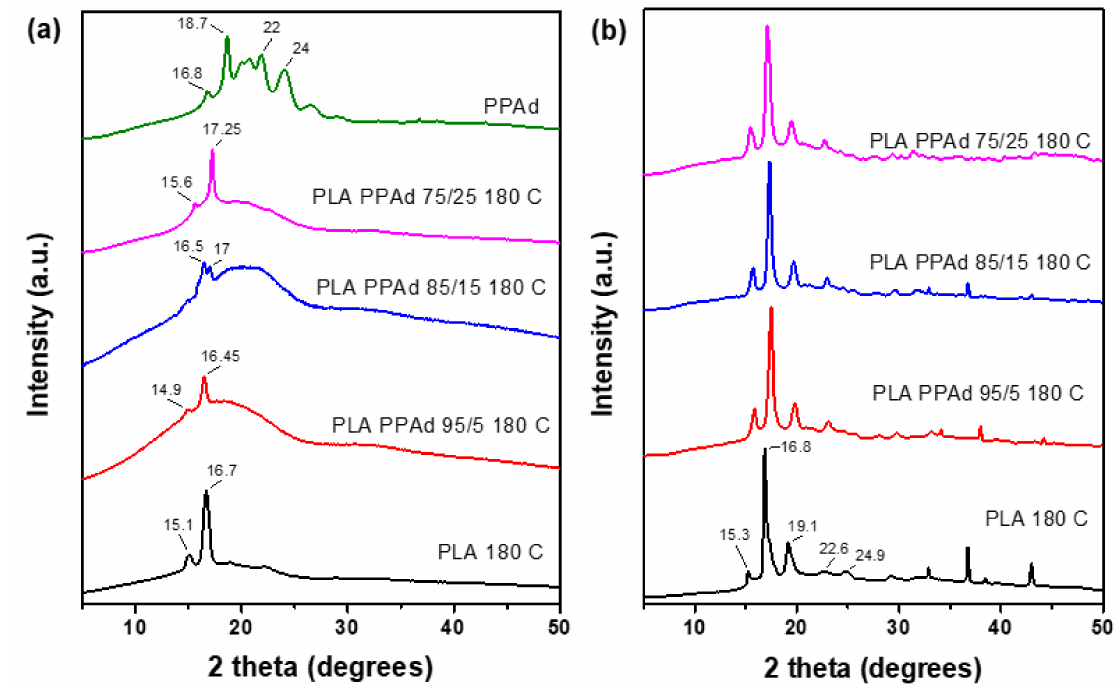
Figure 7. X-Ray diffractograms of PPAd, PLA and their copolymers ( a ) as received from the extruder and ( b ) after cold-crystallization at 85 ◦ C for 1